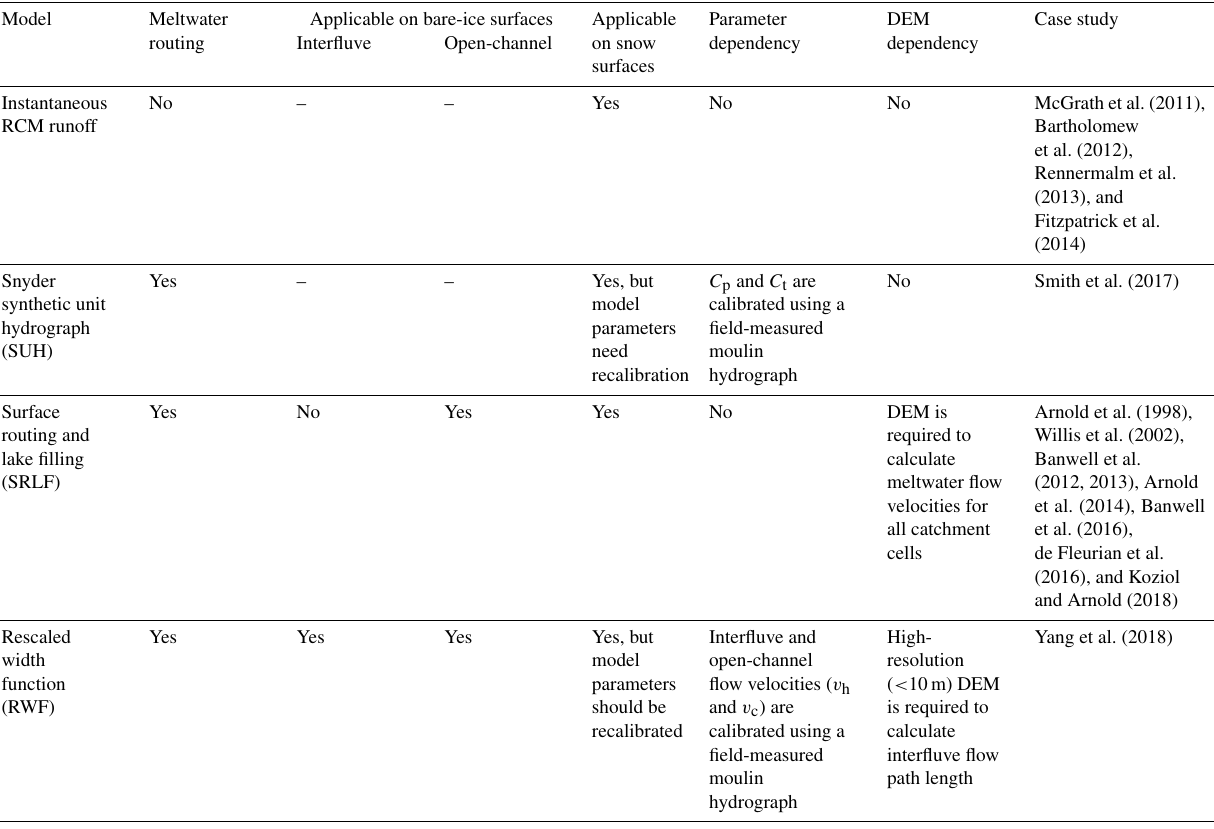
Table 1. A brief summarization of surface meltwater routing models.